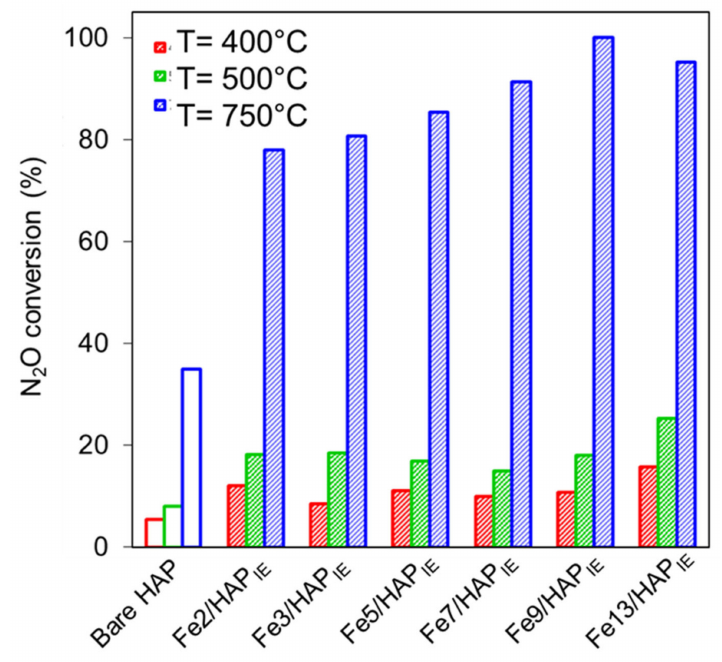
Figure 4. N 2 O decomposition catalytic activity results on Fe / HAP samples: N 2 O conversion at di ff erent temperatures (400, 500, 750 ◦ C). Reaction conditions: [N 2 O] = 150 ppm, [O 2 ] = 6000 ppm; GHSV = 30,000 h − 1